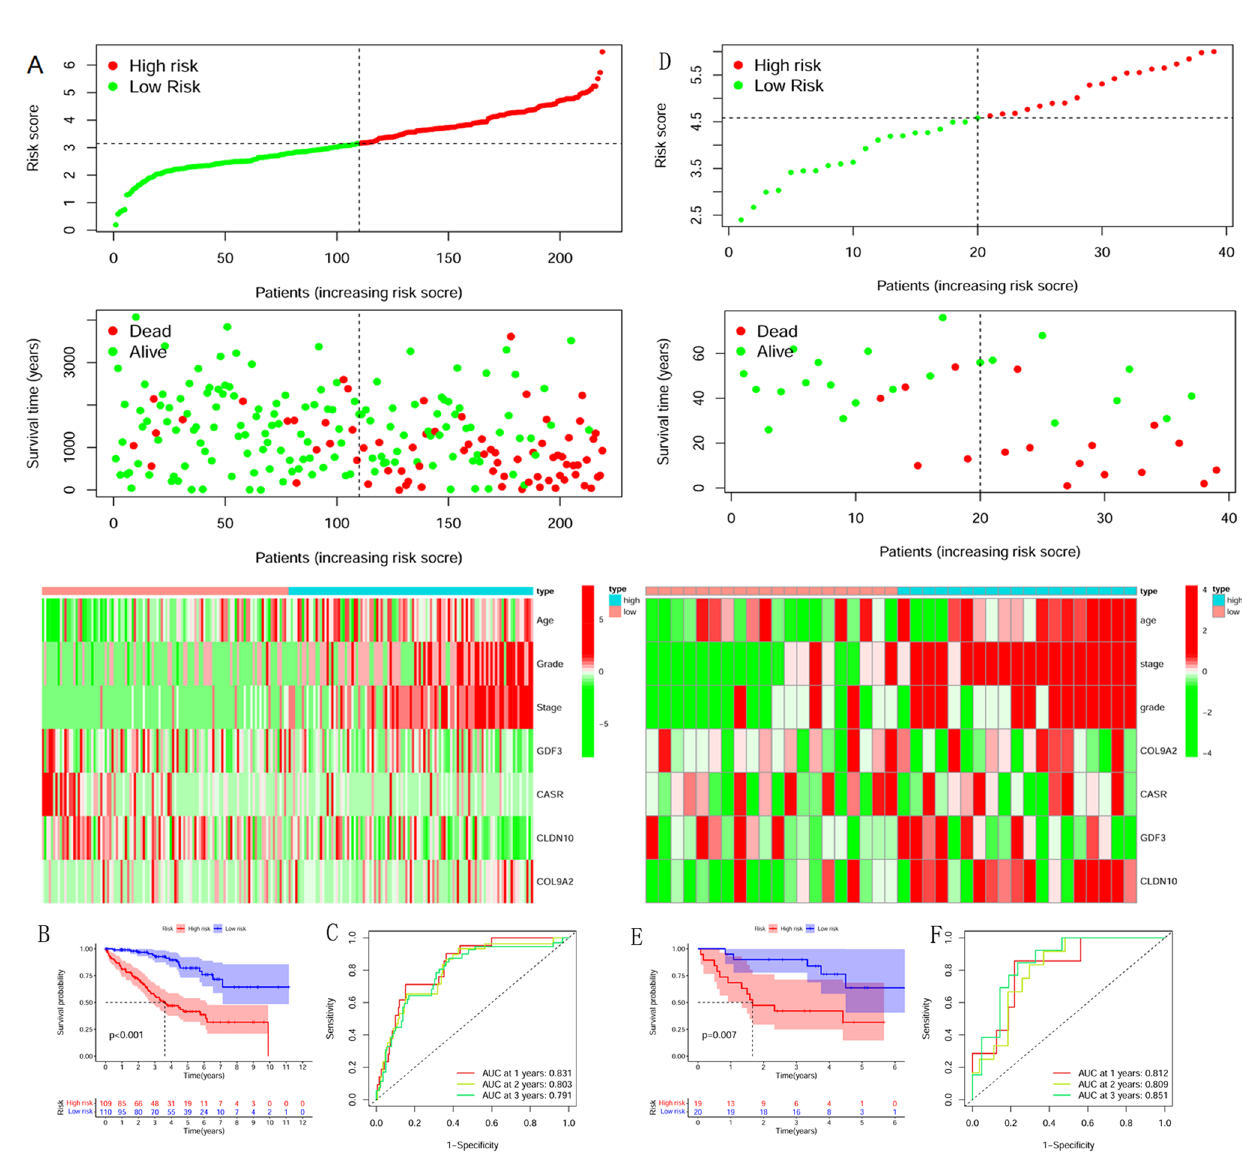
Figure 6. Test Set Validation in R 3.6.2(https:// www.r- proje ct. org/). ( A ) TCGA Test Set Risk Curve and Risk Heat Map. ( B ) TCGA Test Set Survival Curve. There was a significant difference in survival between the high and low-risk groups. ( C ) TCGA Test Set ROC Curve. The prediction accuracy for survival at 1, 2, and 3-years was 0.831, 0.801, and 0.791, respectively. ( D ) GSE29609 Test Set Risk Curve and Risk Heat Map. ( E ) GSE29609 Test Set Survival Curve. ( F ) GSE29609 Test Set ROC Curve. The prediction accuracy for survival at 1, 2, and 3-years was 0.812, 0.809, and 0.851,